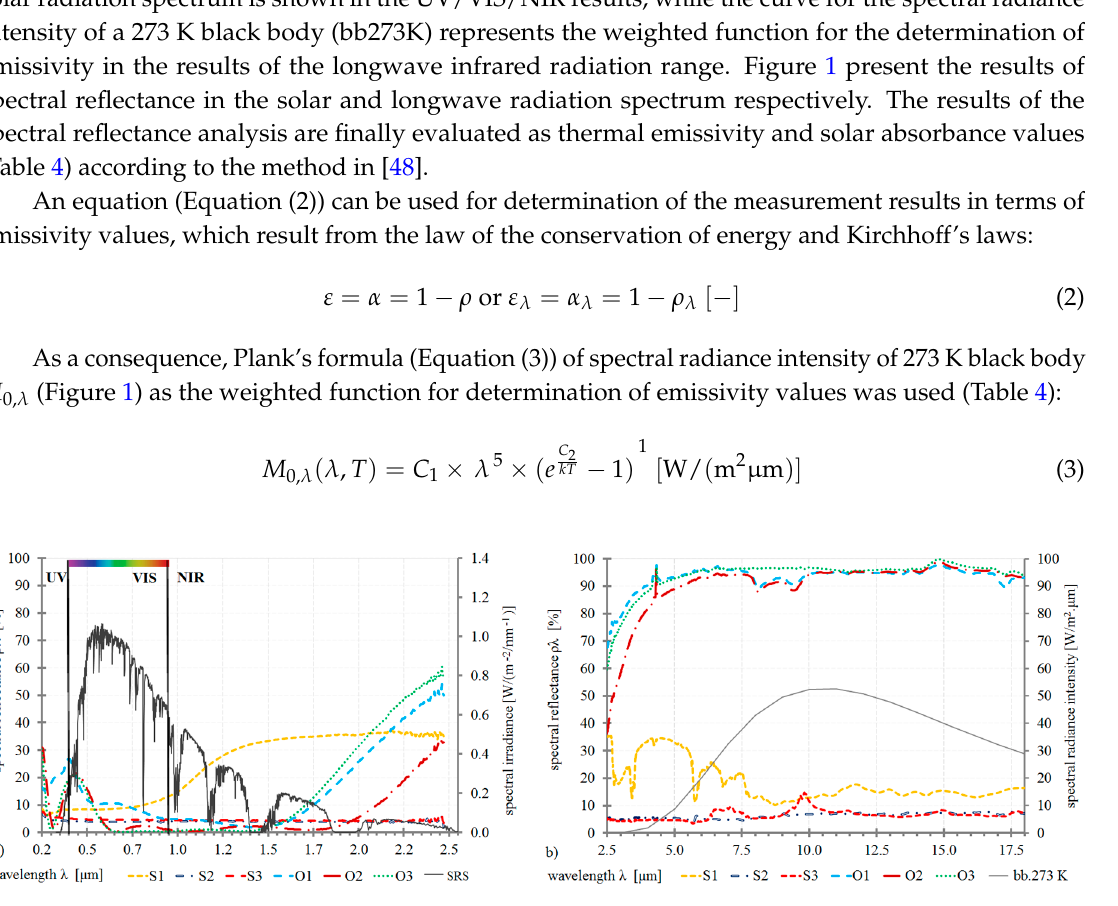
Figure 1. Spectral analysis of absorber samples; ( a ) Spectral reflectance for solar region UV/VIS/NIR; ( b ) spectral reflectance for infrared region. Table 4. Total spectral emissivity ε λ and reflectance ρ λ as weighted values in measured IR spectrum.